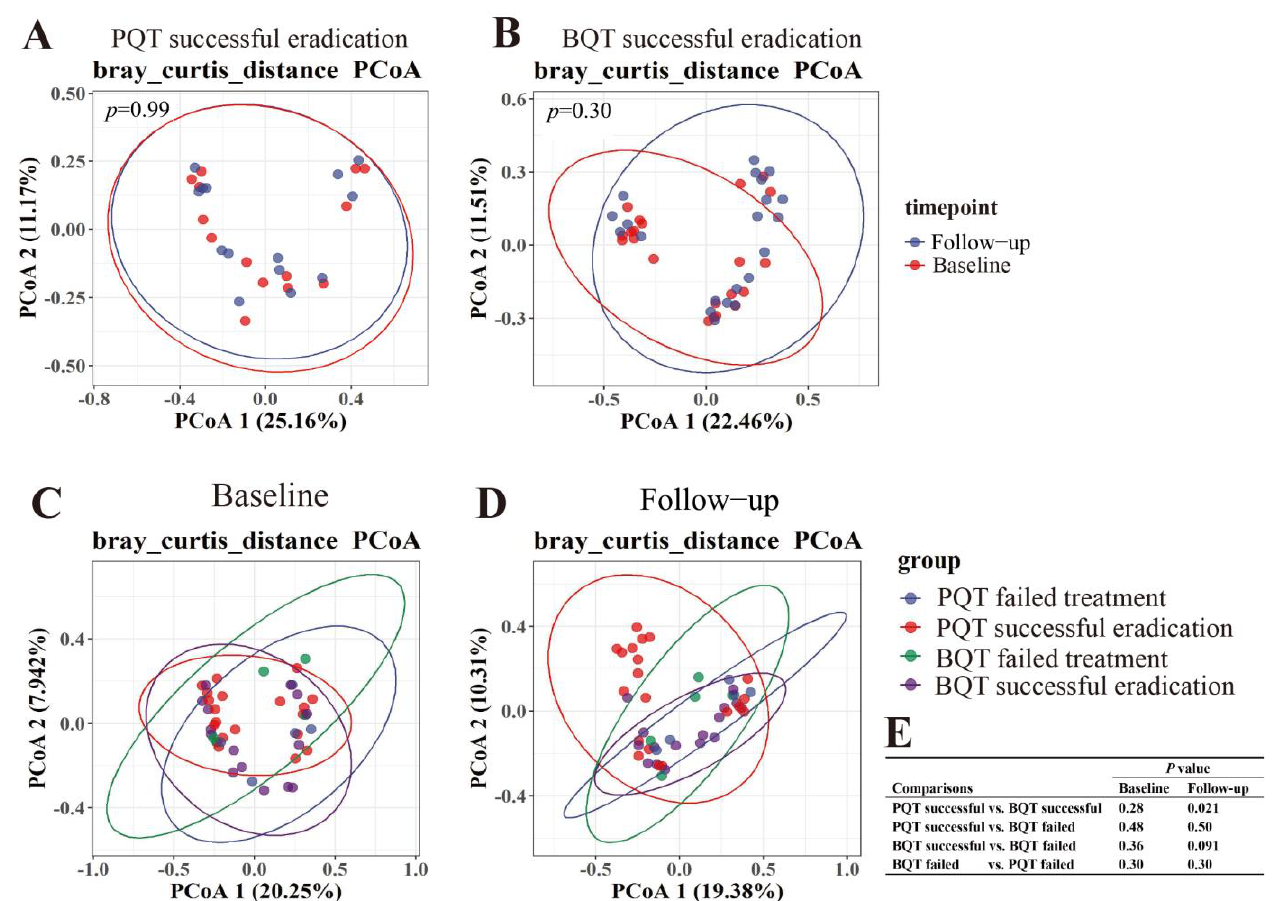
Figure 3. Comparisons of beta diversities. Beta diversity (PCoA) was compared with the baseline in PQT successful eradication group ( A ) and BQT successful eradication group ( B ). Beta diversity was compared among the four groups at baseline ( C ) and follow-up ( D ). ( E ): p -adjusted values of the multiple comparisons. PQT, polaprezinc-containing therapy; BQT, bismuth-containing therapy.